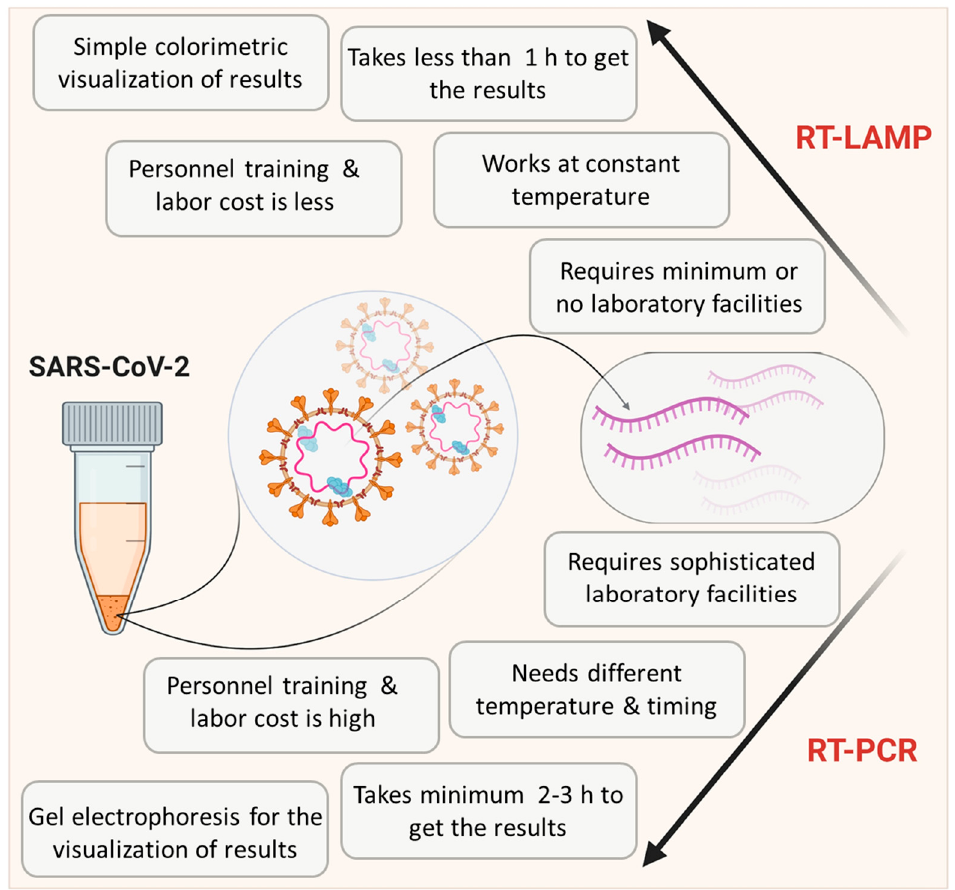
Figure 1. Scheme showing the comparison of reverse transcription loop-mediated isothermal amplification (RT-LAMP) with RT-PCR. Data is adapted from Dhama et al. [19].